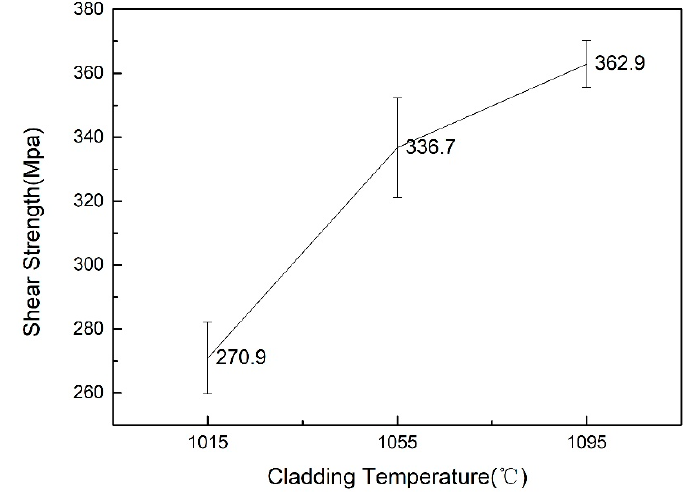
Figure 11. Shear strength of three coatings.